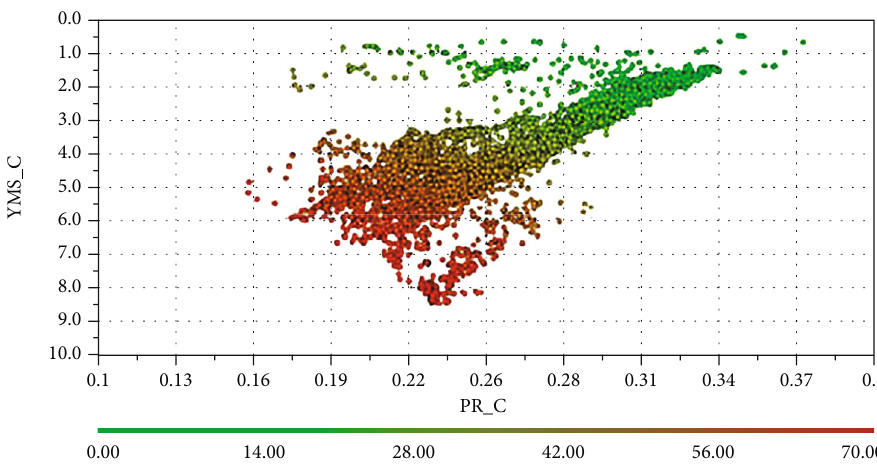
Figure 3: The in fl uence chart of brittleness between the elastic modulus and Poisson ratio